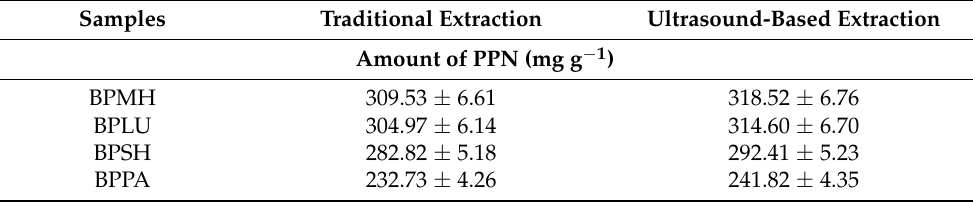
Figure 5. Densitometry chromatograms of PPN in methanolic extract of black pepper (BPPA) rec- orded using normal-phase HPTLC technique.